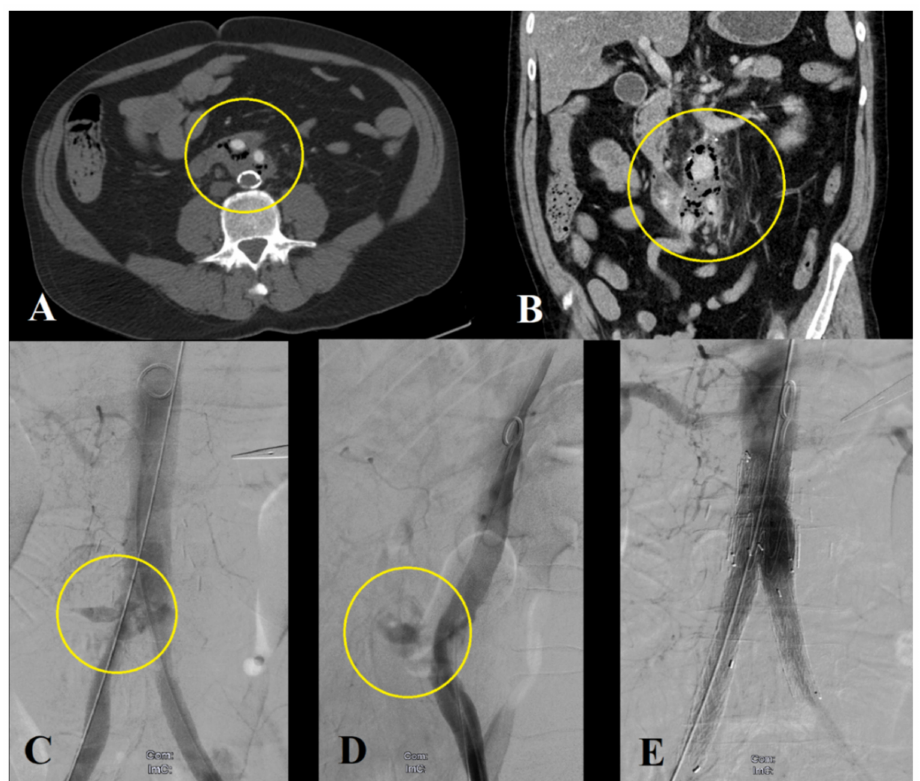
Figure 4. Emergency endovascular management of a patient with acute life-threatening bleeding due to an aortoenteric fistula. Computer tomography angiography showing air inside the aortic wall ( A , B ), (Department of Radiology, University Medical Center Regensburg). Stabilization of the patient with stent-graft implantation in the aorta and the iliac arteries ( C – E